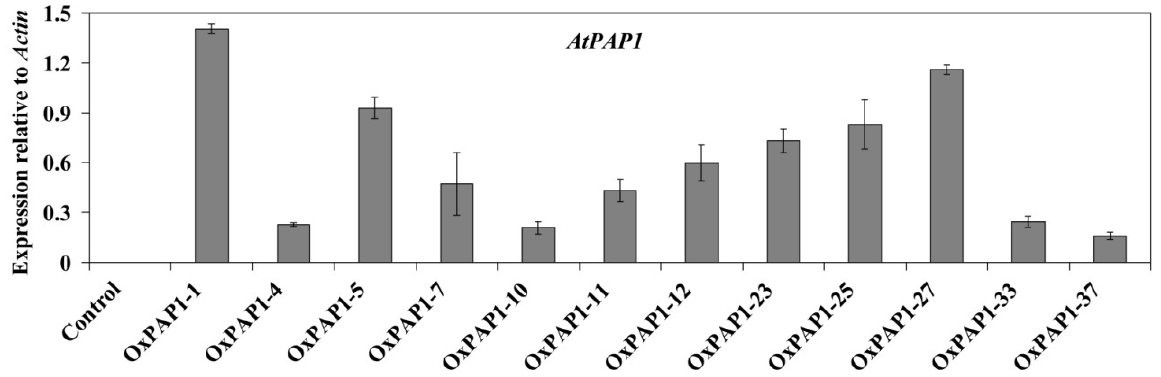
Figure 3. Expression levels of PgPAL1 , PgPAL2 , PgC4H , Pg4CL , PgC3H , PgHCT , and PgHQT in the P. grandiflorum OxPAP1-1 hairy root line. Control hairy roots